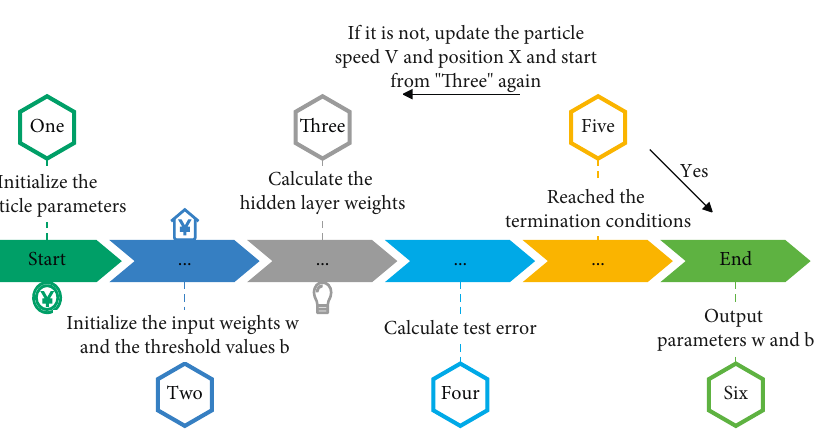
Figure 5: Flow chart of particle swarm